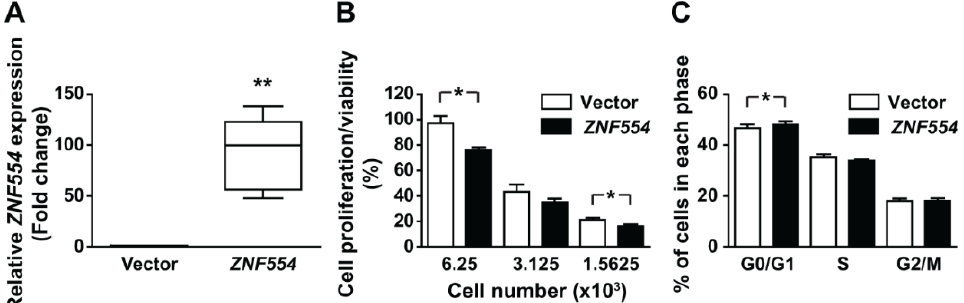
Figure 3. Overexpression of ZNF554 decreases cell proliferation and induces cell cycle arrest in U87 glioblastoma cells. ( A ) Box plots (median and whiskers: 1–99 percentile) represent the relative gene expression level of ZNF554 in U87 cells two days after transient transfection with pCMV-ZNF554 or empty vector. Quantitative RT-PCR data are from five independent experiments. Unpaired t-test with Welch correction was used for the statistical analysis (** p < 0.01). ( B ) Analysis of cell proliferation/viability of vector- and ZNF554 -transfected U87 cells by the Cell Counting Kit-8 assay. The percentage of cell proliferation relative to the vector-transfected control cells are presented as the mean ± SEM. ( C ) Analysis of cell cycle distribution of vector- and ZNF554 -transfected U87 cells by Hoechst33342 staining and flow cytometry. Percentage of cells (mean ± SEM) in G0/G1, S, and G2/M phases are shown. Data were retrieved from three-four independent experiments. Paired t-test was used for the statistical analysis (* p < 0.05).